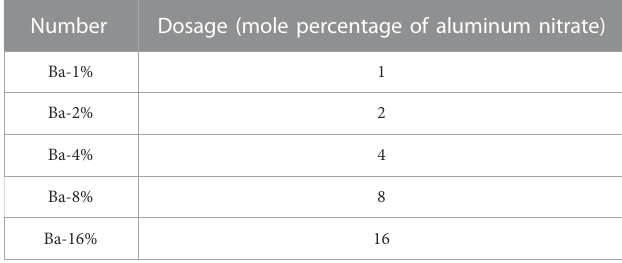
TABLE 4 Experimental formula of different addition amounts of barium